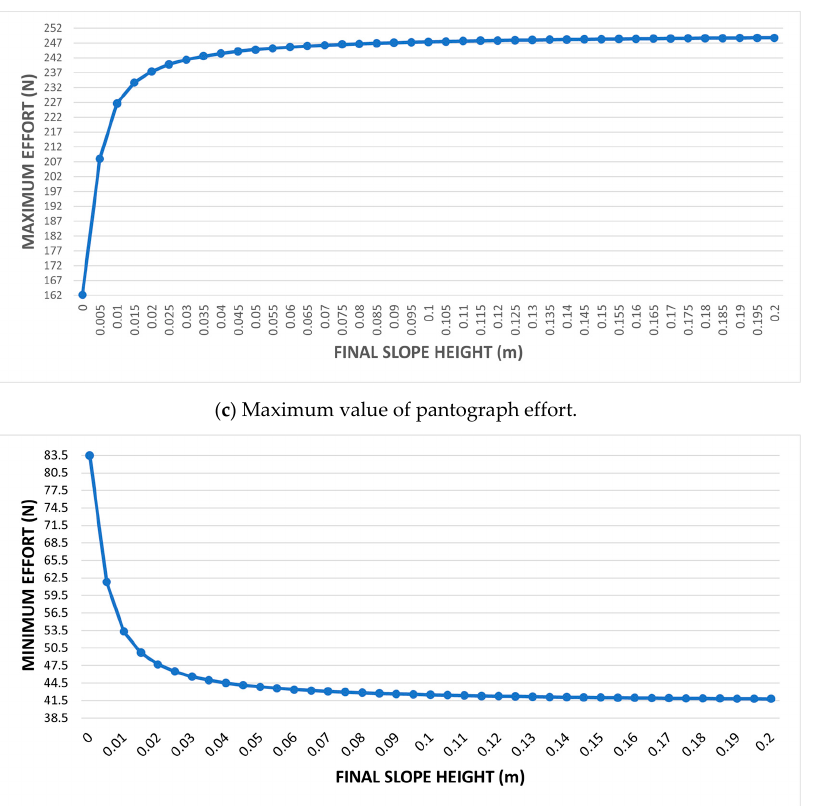
Figure 10. Graphs of simulation 1: an overlapping span of 1 m, slope length 1 m, and variation in the height of the slope at its end. ( a ) Average value of pantograph effort, ( b ) standard deviation of pantograph effort, ( c ) maximum value of pantograph effort, and ( d ) minimum value of pantograph effort.